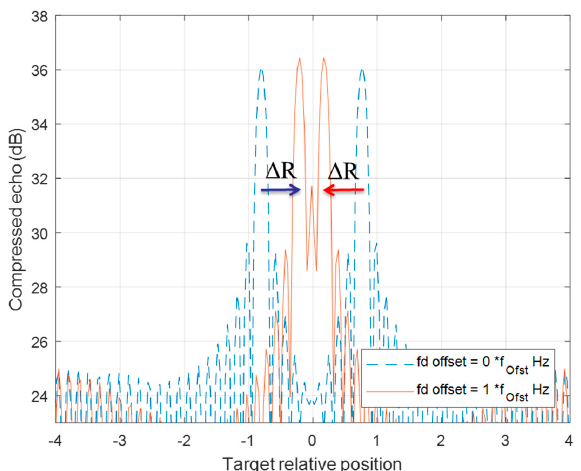
Figure 8. The range offset of a two-chirp detection pair of a moving target is processed by one fd_offset DSC. Two detections both have Δ R offset, but in the opposite direction.